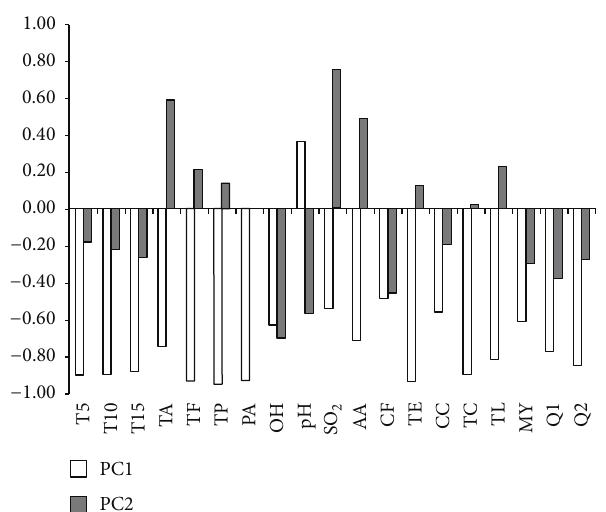
Figure 4: Loading plot reporting PC1 versus PC2. The following abbreviations were used: T5, T10, and T15: wine free-radical scav- enging activity after 5, 10, and 15 minutes, TA: total anthocyanin index, TF: total flavonoid index, TP: total phenol index, PA: proan- thocyanidin index, OH: ethanol content (%vol.), pH: wine pH value, SO 2 : free SO 2 content, AA: ascorbic acid concentration, CF: cis - caffeoyl tartaric acid concentration, TE: trans -caffeoyl tartaric acid concentration, CC: cis - p -coumaroyl tartaric acid concentration, TC: trans - p -coumaroyl tartaric acid concentration, TL: trans -feruloyl tartaric acid concentrations, MY: myricetin concentration, Q1: quercetin glucoside concentration, and Q2: quercetin glucuronide